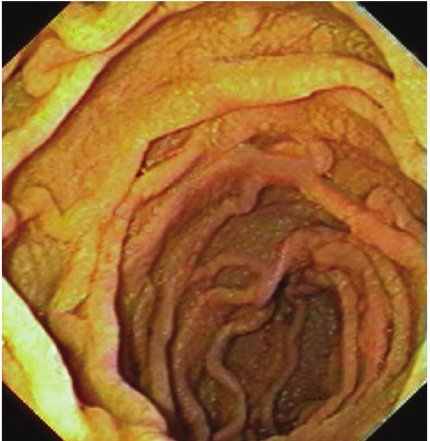
Figure 10: Whipple’s disease: control enteroscopy after two-month treatment (with doxycycline and salazopyrine). Picture of the distal duodenum. Folds are still lower with chaotic disarrangement but macroscopically picture of mucosa has significantly improved.